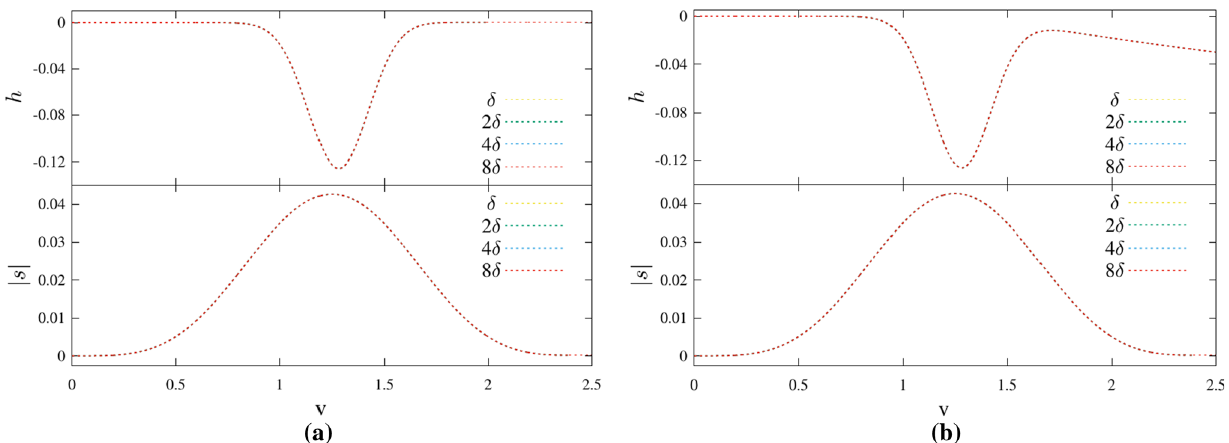
Fig. 17 The convergence of field functions. The scalar field, h , and the moduli of complex scalar field, | s | , were plotted versus v for evolutions conducted with integration steps, which were multiples of δ = 10 − 4 , along hypersurfaces of constant u equal to 1 for a Evolution 1 and b Evolution